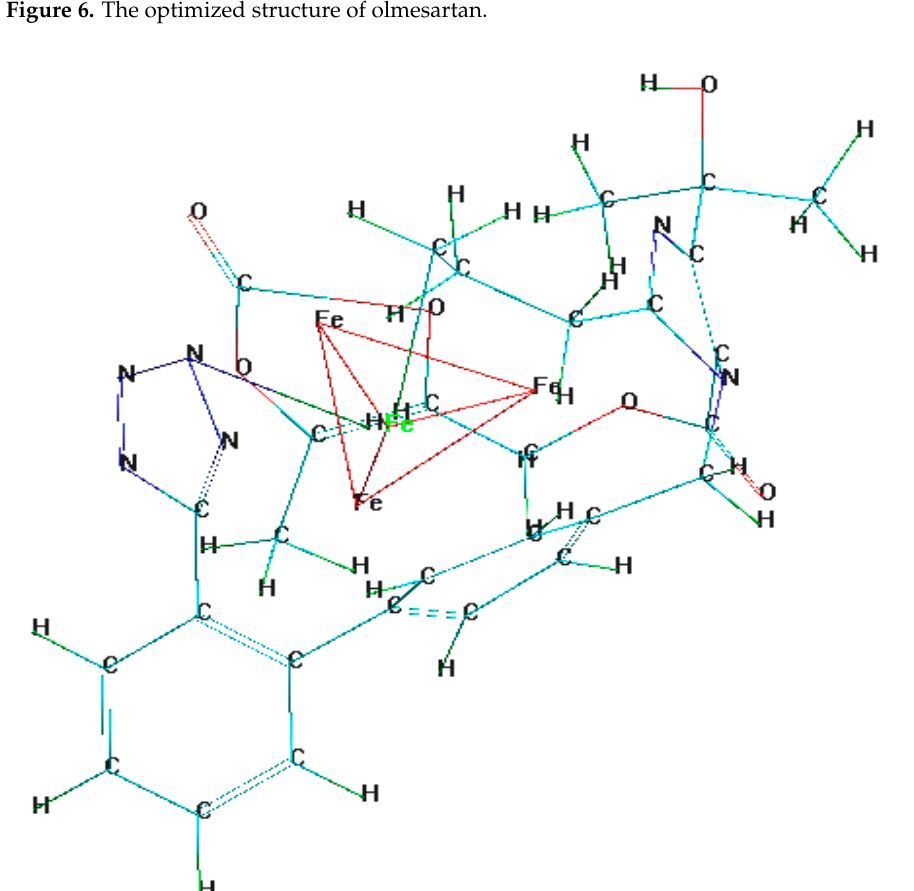
Figure 7. Interaction of Fe +4 with olmesartan molecular dynamics.